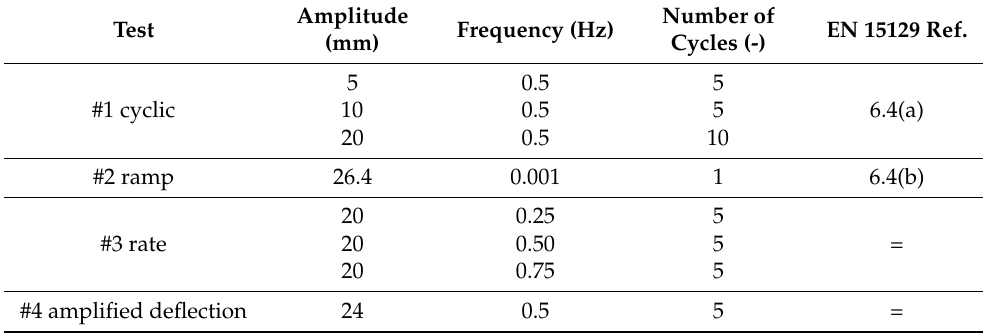
Table 2. Testing